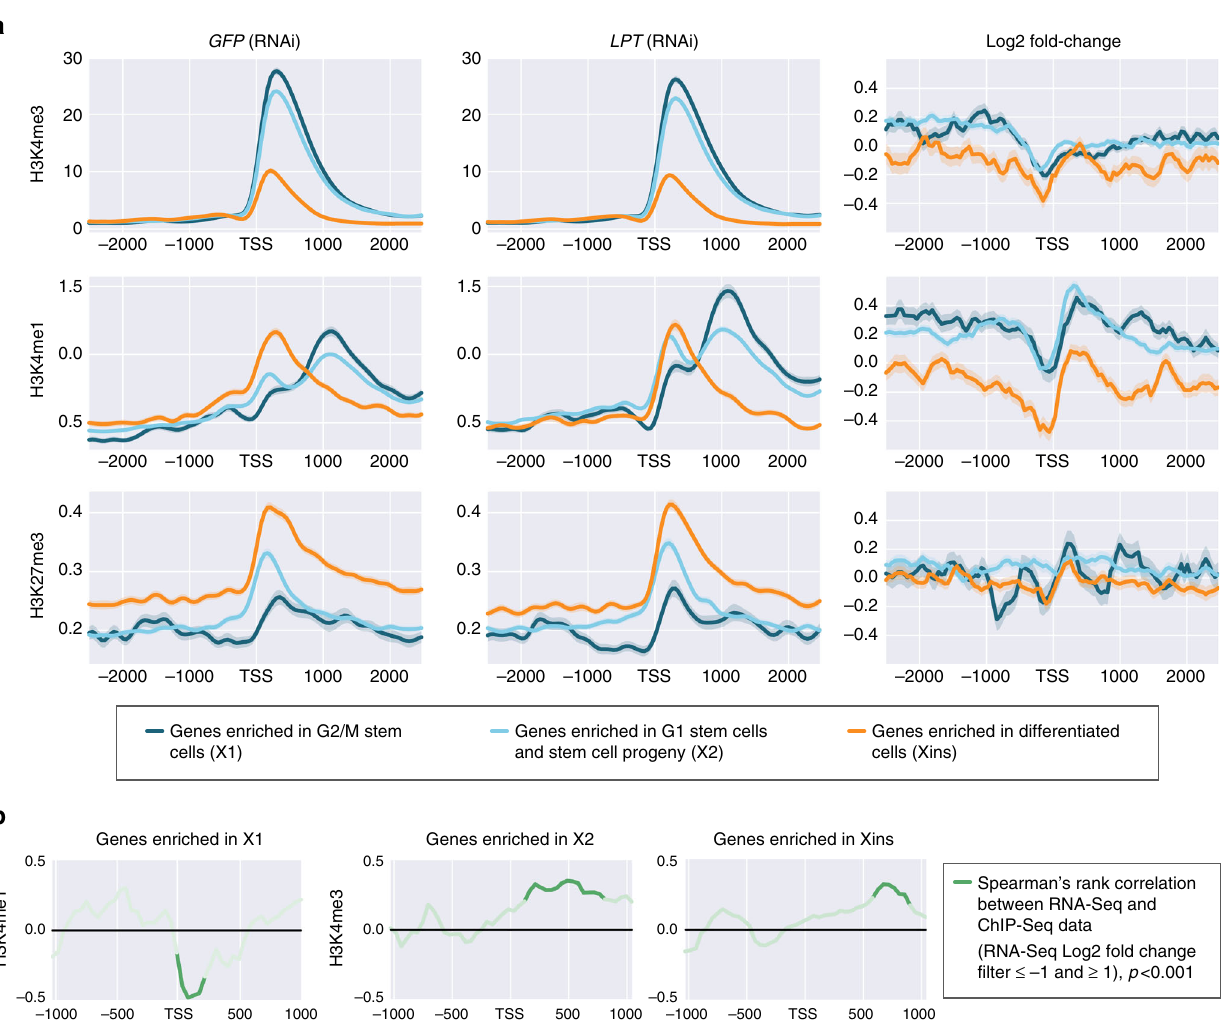
Fig. 8 LPT (RNAi) is mainly manifested in changes in H3K4me1 and H3K4me3 around the TSS in G2/M (X1) stem cells. a Graphs presenting the average read coverage across the genome for H3K4me3, H3K4me1 and H3K27me3 after performing ChIP-seq on X1 (G2/M stem cells). The graphs are centered on the TSS (showing 2 kb upstream and downstream) and the data is normalized to Drosophila S2 signal spike-in. The input coverage is subtracted. Log2 fold change graphs are also shown for each histone modi fi cation, where signal above zero shows increase following LPT (RNAi) and signal below zero represents a decrease. Three colors are used for different gene classes — dark blue (genes enriched in G2/M stem cells, i.e., X1), light blue (genes enriched in G1 stem cells and stem cell progeny, i.e., X2), orange (genes enriched in differentiated cells, i.e., X ins). Standard deviation is shown by a faded color around each line. b Spearman ’ s rank correlation between changes in RNA-seq signal following LPT (RNAi) and H3K4me1 or H3K4me3 ChIP-seq signal for the region around the TSS of genes from different enrichment classes (only examples where a signi fi cant correlation exists are shown). The green line shows a correlation where RNA-seq fold change data was fi ltered for Log2 fold changes ≤ − 1 and ≥ + 1. Faded areas of the lines represent results not signi fi cant at p < 0.001, while darker colors represent results signi fi cant at p <